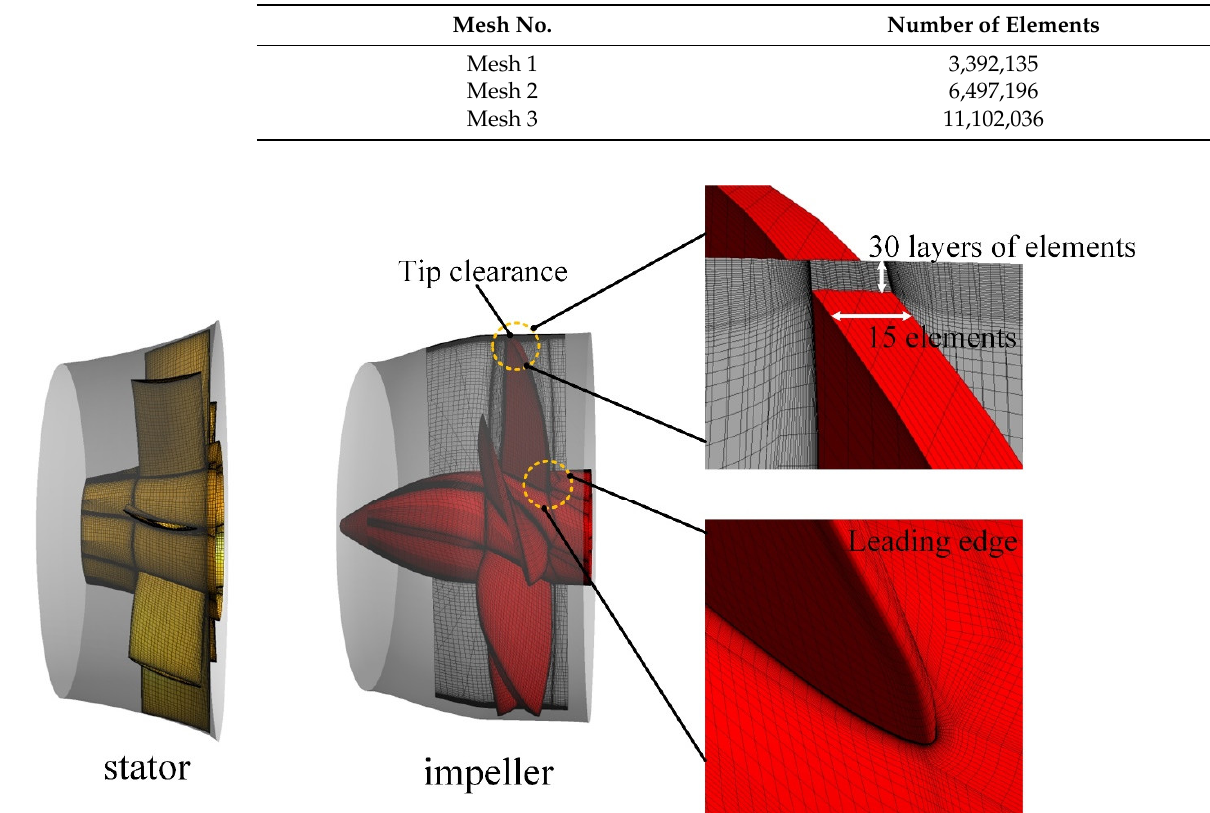
Figure 2. Structured mesh in the pump for Mesh 2.